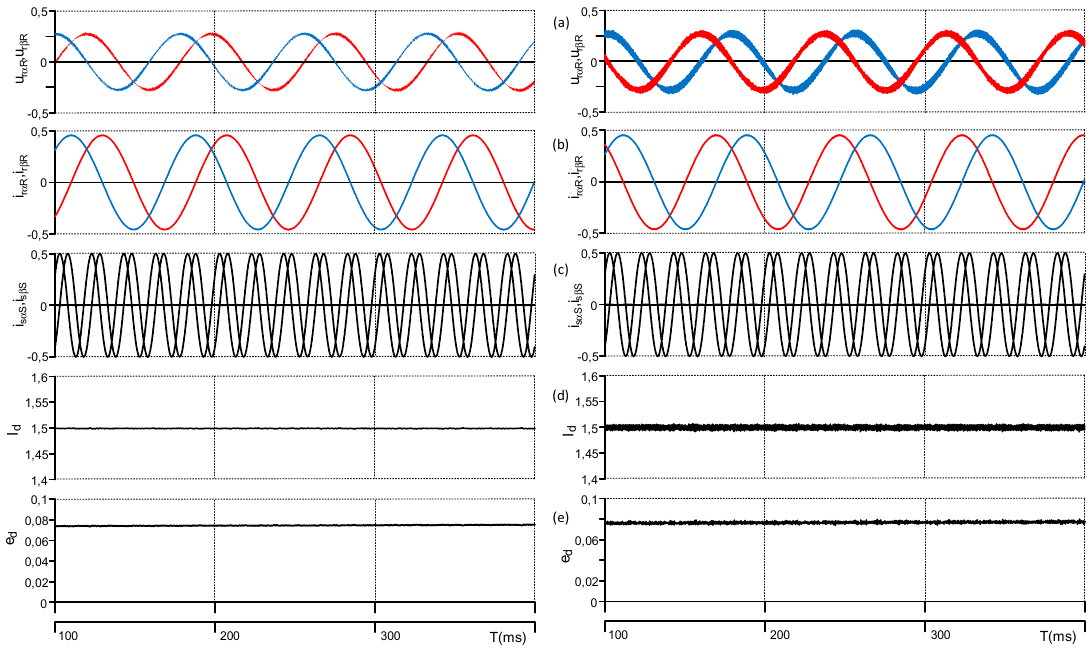
Figure 4. Simulation results: steady-state transients for different values of the main choke inductance: ( left ) L d = 0.05, Cm = 0.35; ( right ) L d = 0.02, Cm = 0.35. ( a ) Rotor voltage vector components; ( b ) rotor current vector components; ( c ) stator current vector components; ( d ) current in the DC link circuit; ( e ) voltage in the DC link circuit.